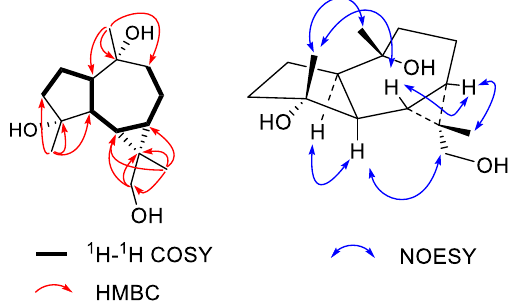
Figure 4. Key 1 H- 1 H COSY, HMBC, and NOESY correlations of 3 . Compound 4 was obtained as a colorless viscous oil. The molecular formula of 4 was C 15 H 22 O 4 as determined by the HRESIMS peak at m/z 265.1441 ([M − H] + , calcd.